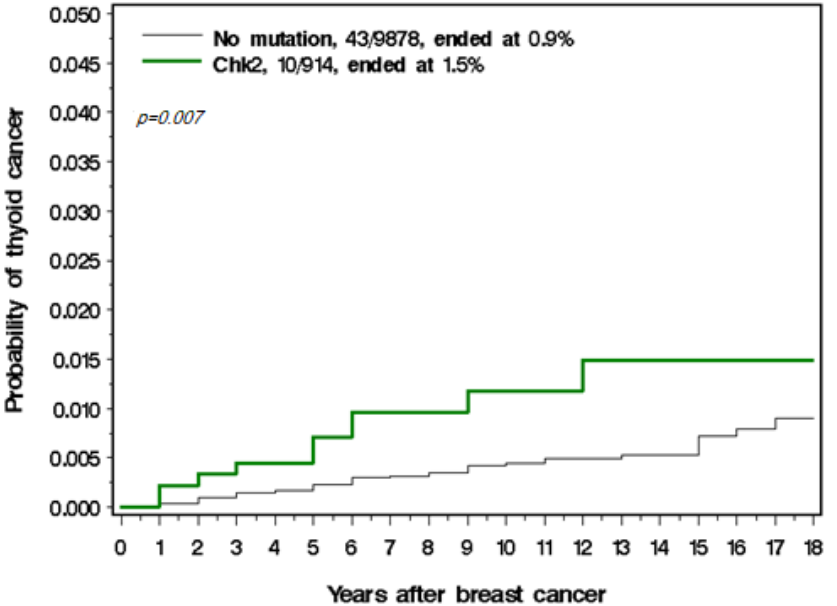
Figure 1. Cumulative incidence of thyroid cancer in those with and without a CHEK2 mutation. Table 4. Hazard ratios for thyroid cancer after breast cancer, selected